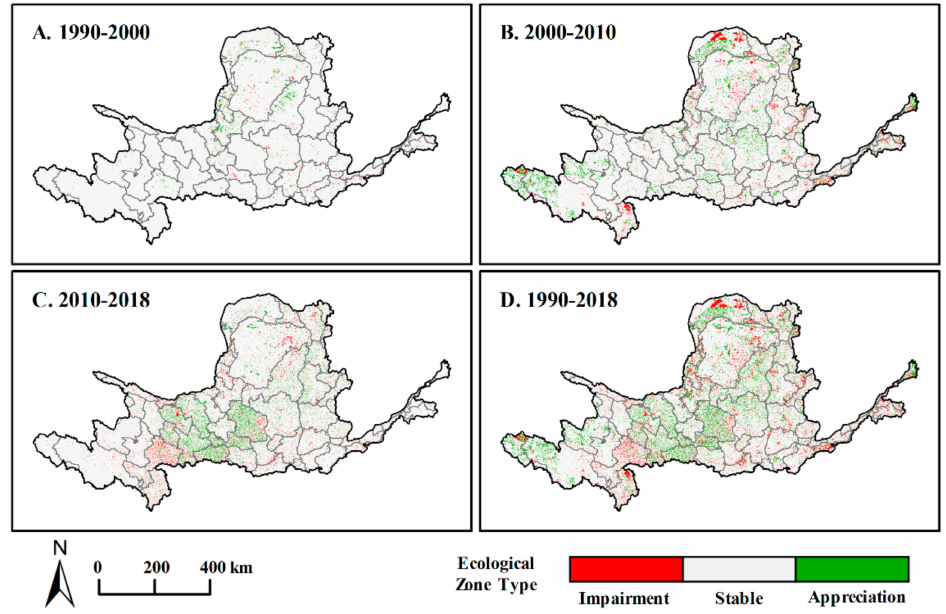
Figure 8. Tupu of changes in ESV from 1990 to 2018 in the